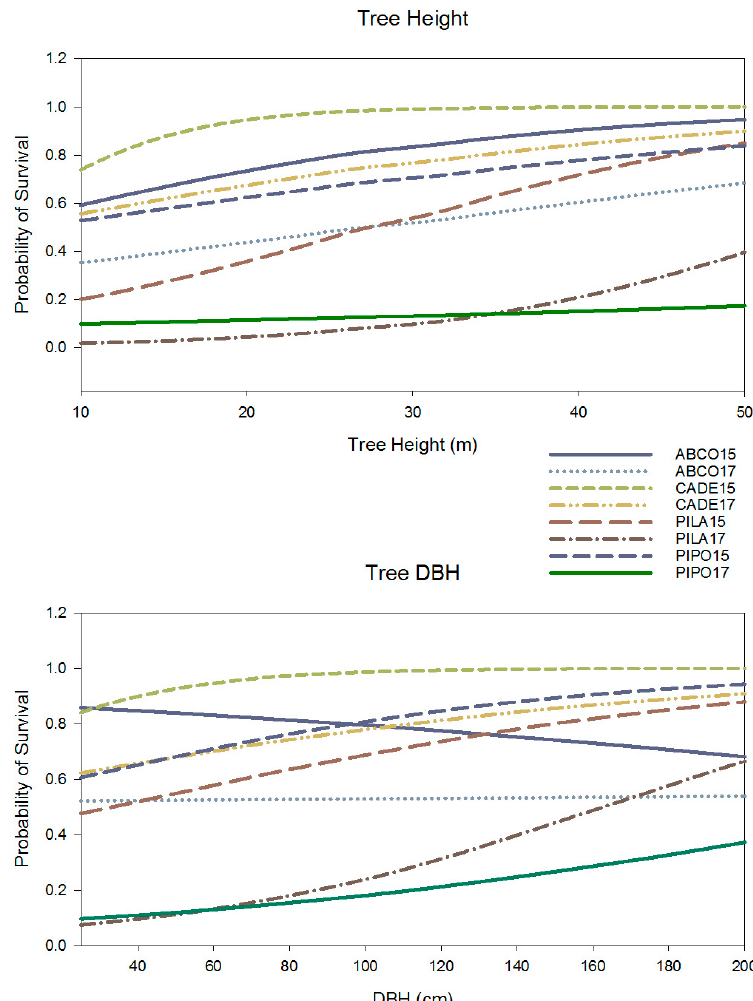
Figure 4. Probability of survival by species based on logistic regression for individual tree height (upper insert; m) and tree DBH (lower insert; cm) in Spring 2015 and Summer 2017 in the Southern